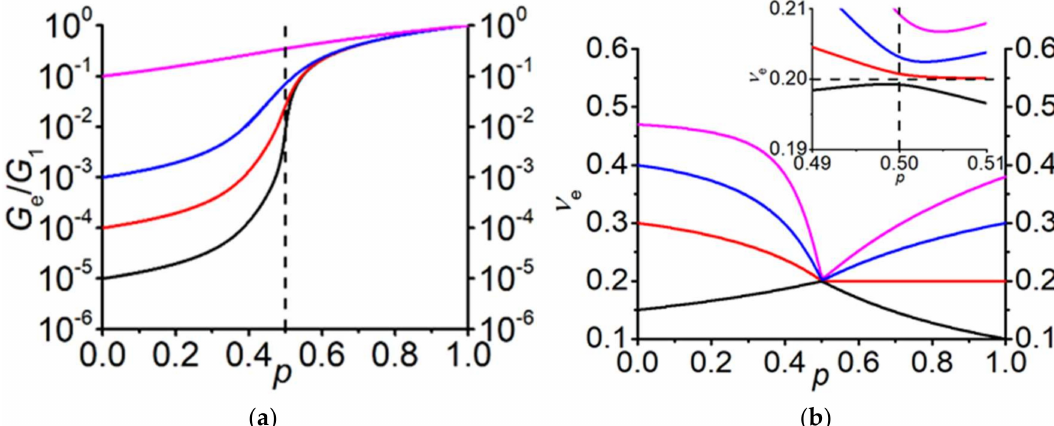
Figure 3. ( a ) Concentration dependence of the normalized e ff ective shear modulus G e / G shear moduli of the second phase. G 1 = 10 11 Pa, ν 1 = 0.3, ν 2 = 0.49; ( b ) Concentration dependence of the e ff ective Poisson’s ratio for di ff erent combinations of the Poisson’s moduli of the phases. G 1 = 10 11 Pa. The inset shows the enlarged region around the percolation